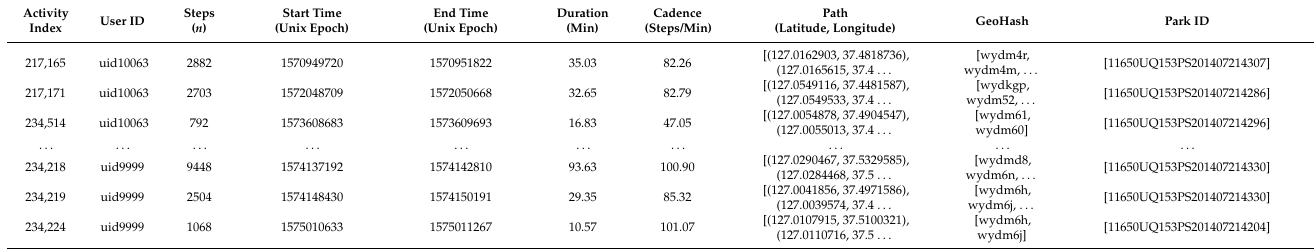
Table A2. Park walking activity, identified by GPS path coordinates, and GIS park